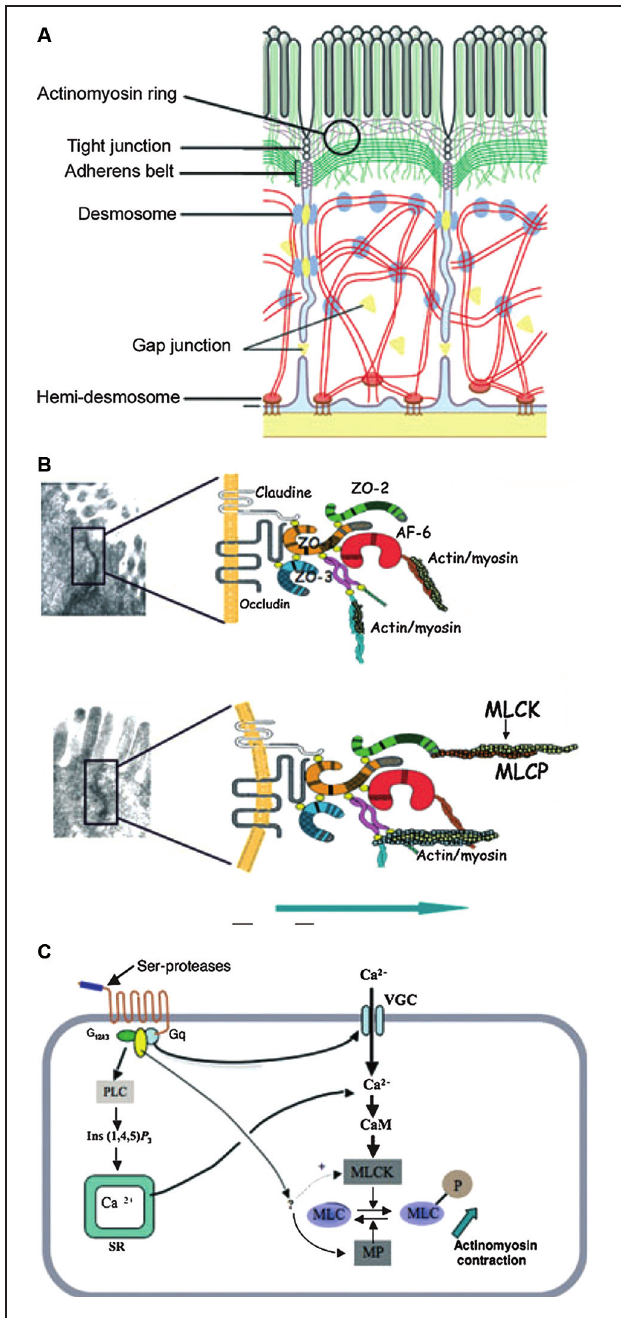
FIGURE 1 | Structures and factors controlling paracellular permeability . Tight junctions are luminal structures that filter the passage of ions and macromolecules (A) . The intercellular structural proteins, claudins and occludins, are anchored to the cytoskeleton actinomyosin apical ring through intermediary proteins (ZO-1, -2, -3, AF6). The phosphorylation of myosin light chain causing contraction is associated with opening of tight junctions and junction protein deformations that favour macromolecule passage and bacterial translocation (B) . The phosphorylation/ dephosphorylation of myosin light chain is controlled by myosin light chain kinase (MLCK) and myosin phosphatase (MP). PAR-2 activation increases MLCK activity through external and internal calcium (Ca++) mobilization and calmodulin binding (C) . (With permission from John Wiley and Sons) (Bueno and Fioramonti,